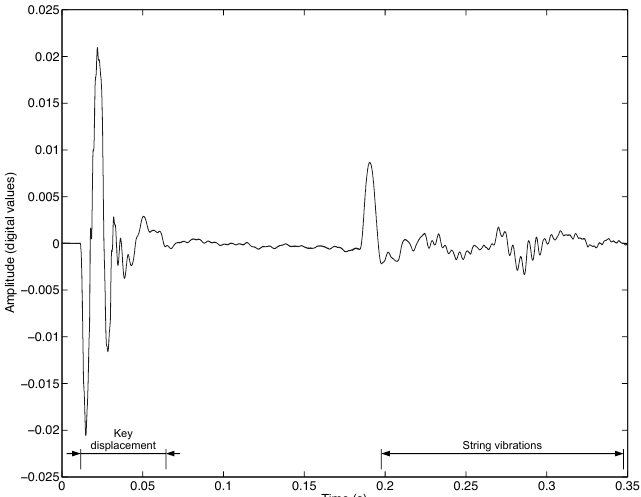
Figure 3. Vibration signal recorded on the grand Disklavier by playing the note A2 at MIDI velocity 12. Picture from